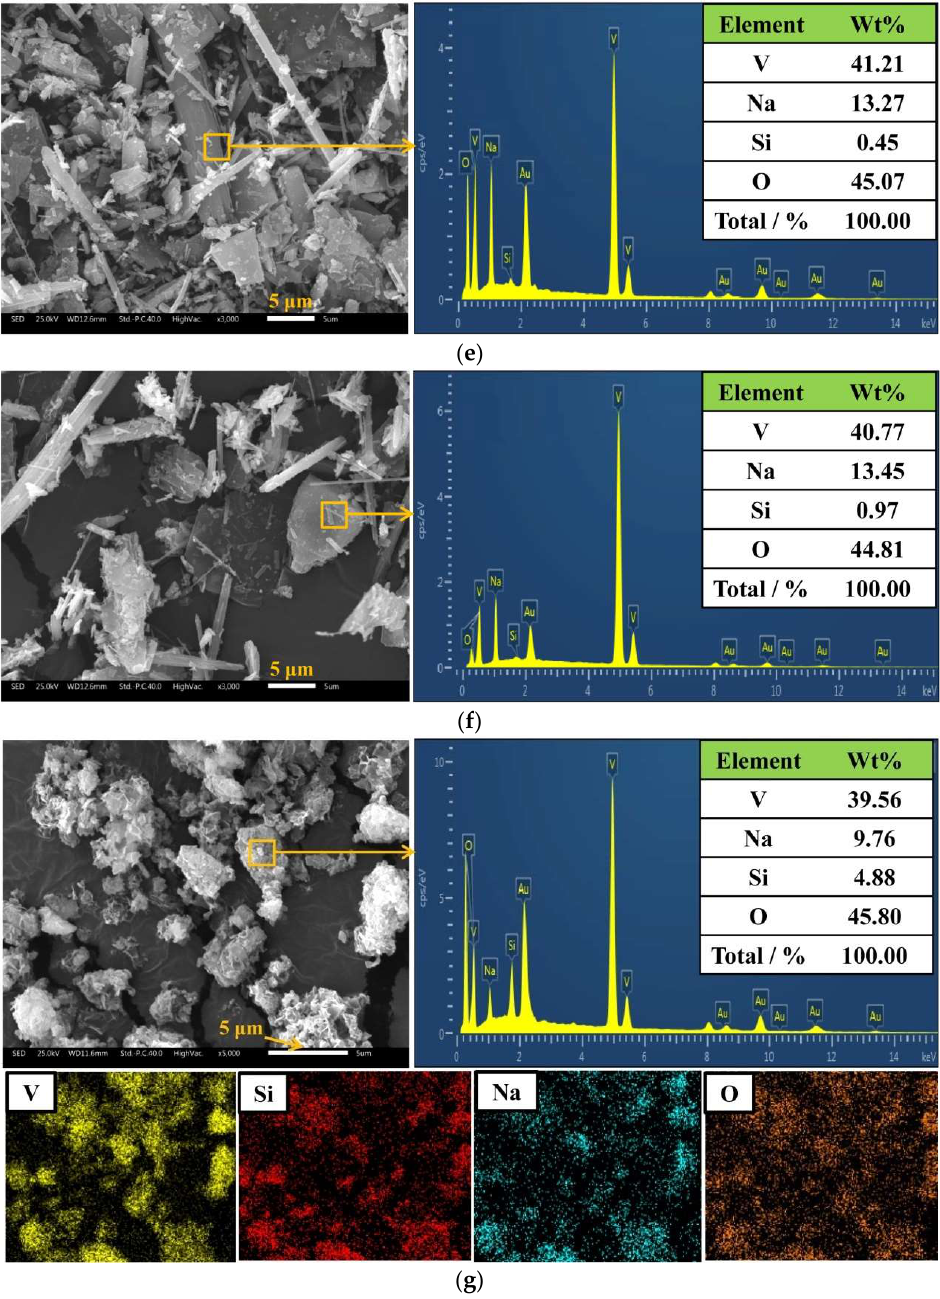
Figure 12. SEM images with X-ray energy dispersive spectroscopy (EDS) analysis of the precipitates obtained at different silicon concentrations of ( a ) 0.1 g/L; ( b ) 0.2 g/L; ( c ) 0.31 g/L; ( d ) 0.39 g/L; ( e ) 0.52 g/L; ( f ) 1.01 g/L, and ( g ) 3 g/L in the feed solutions.